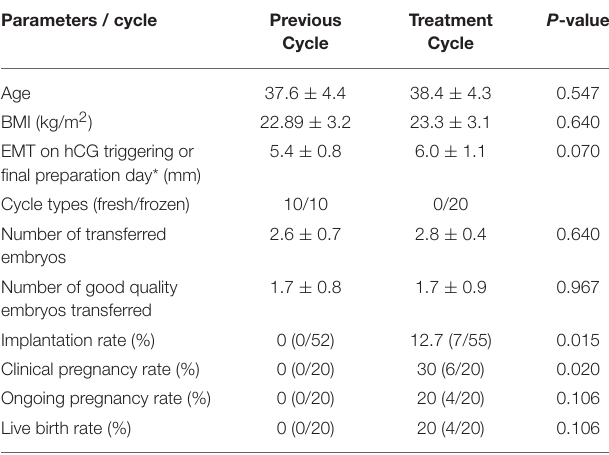
TABLE 3 | Comparison of outcomes between the treatment and the previous cycles. Parameters / cycle Previous